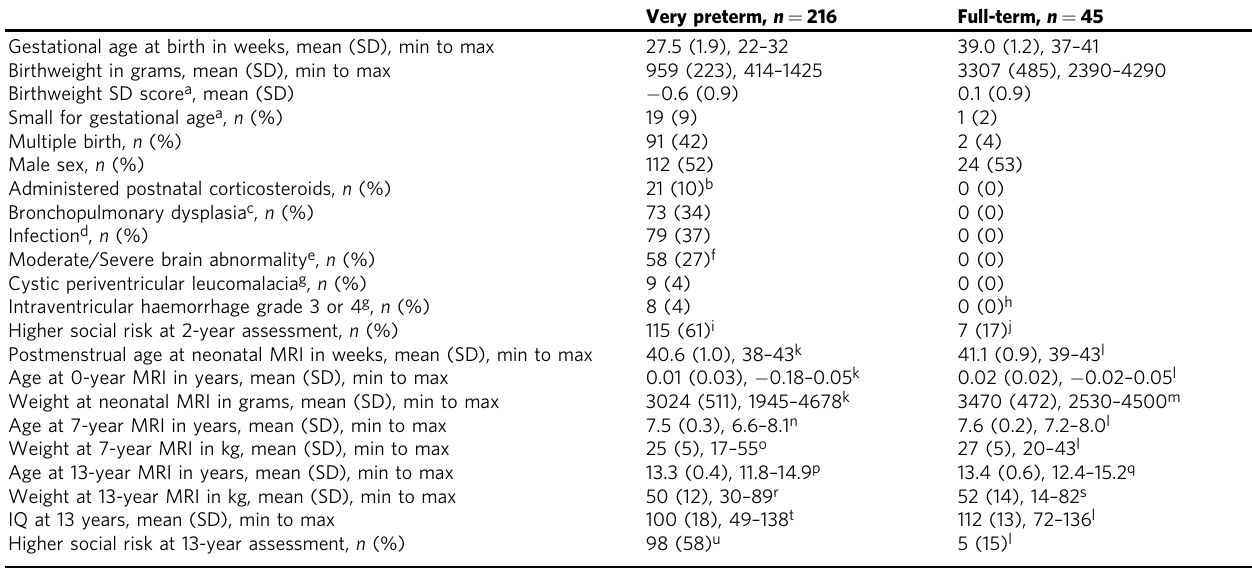
Table 1 Characteristics of the very preterm and full-term participants who contributed any volumetric data at any of the time-